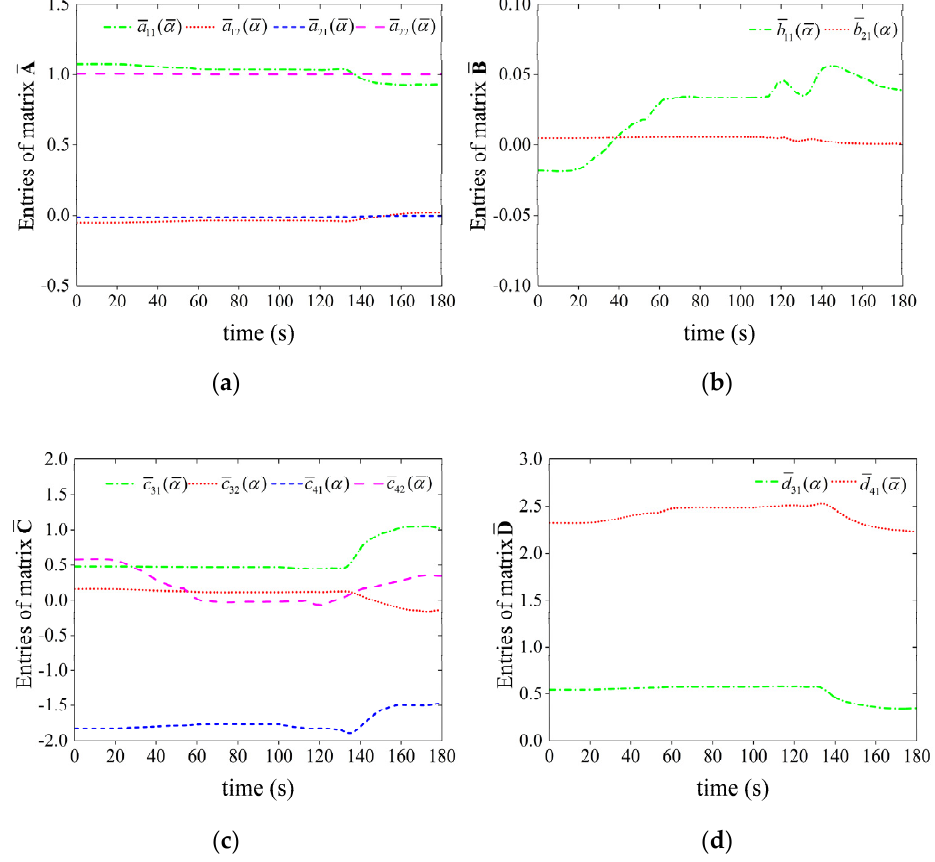
Figure 6. Parameter variations of DD-LPV model (at 1000 m, without measurement noise). ( a ) Entries of matrix A . ( b ) Entries of matrix B ( c ) Entries of matrix C . ( d ) Entries of matrix D .